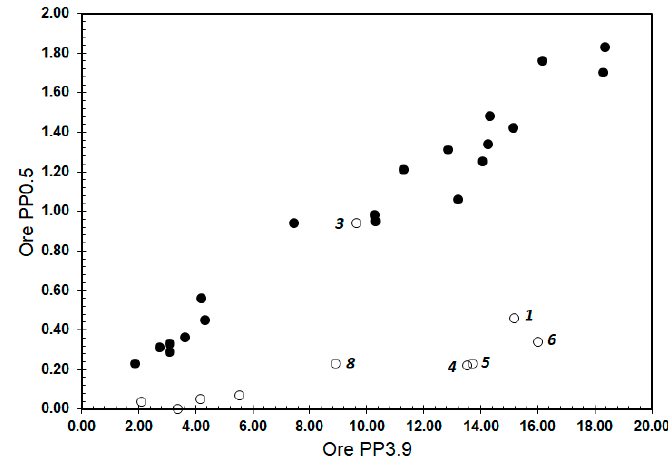
Figure 2. Variability in ore fines (pp3.9%) and ultrafines (pp0.5%) content for both sample suites. Open and filled circles represent sample suites 1 and 2, respectively. Numbers refer to the sample numbers listed in Table 1.